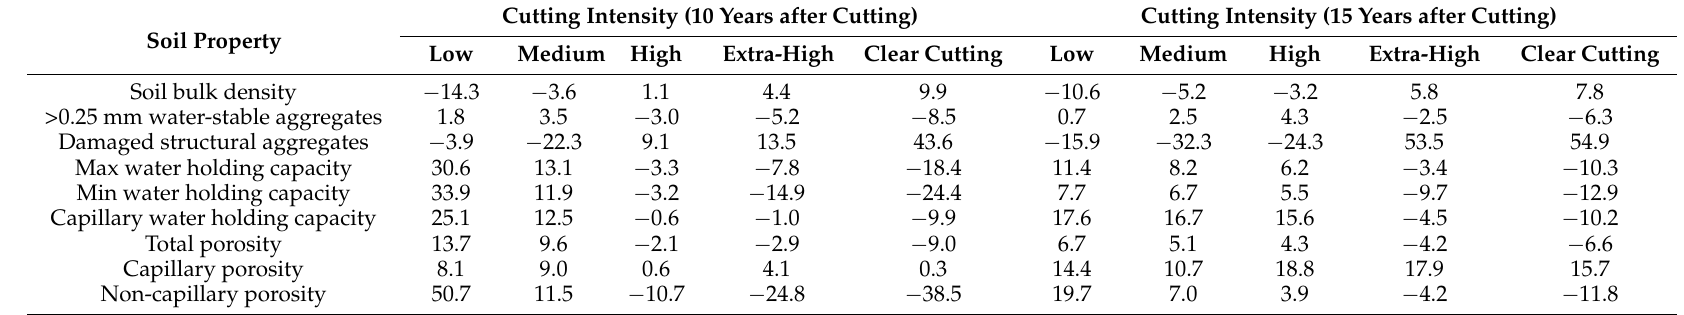
Table 3. Percentage changes in soil physical properties due to different cutting intensities relative to non-cutting.